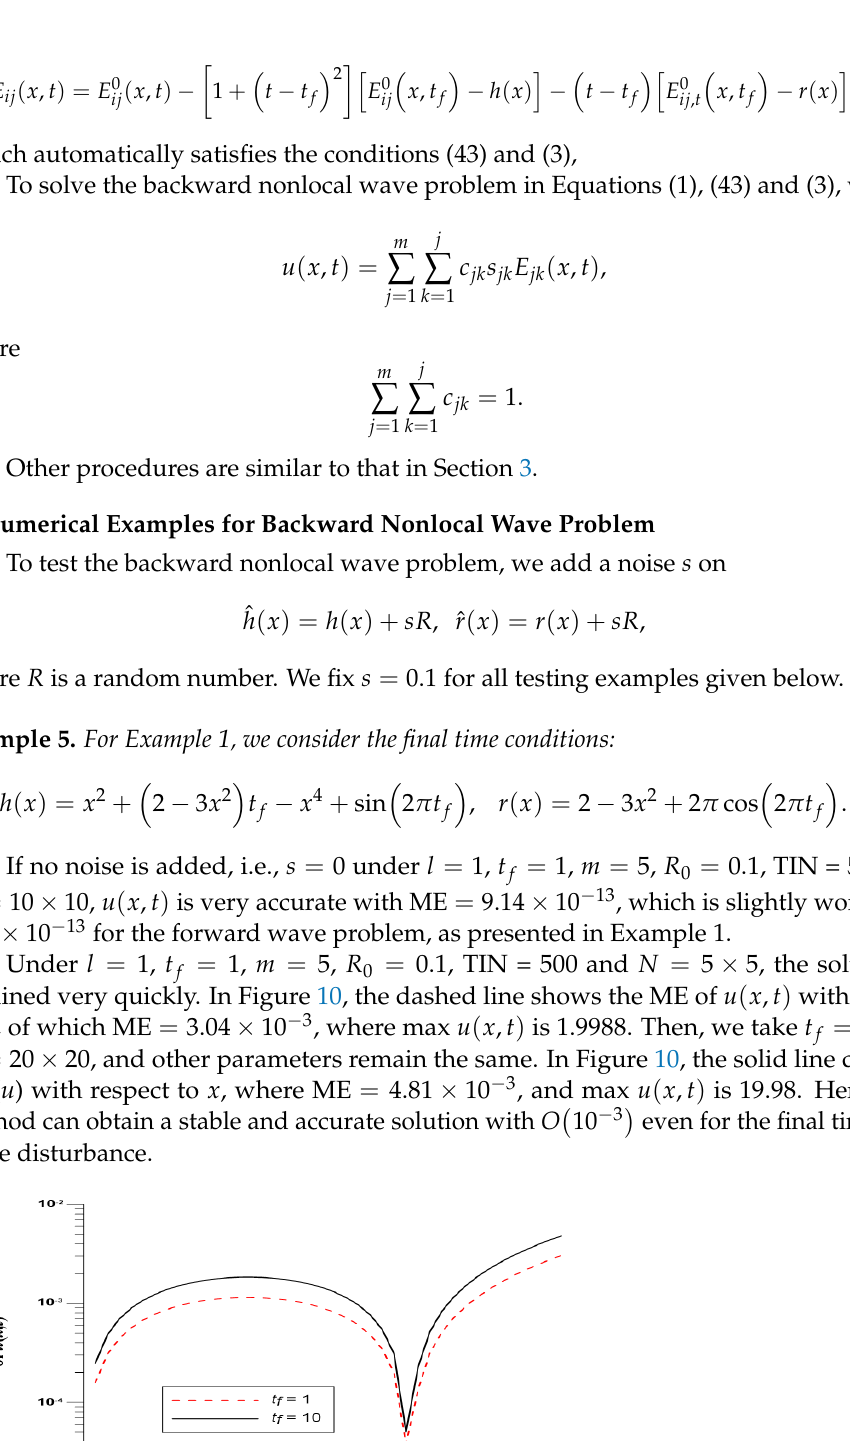
Figure 11. For Example 6 of the backward nonlocal wave problem: ME( u ) versus x in the spatial interval. Figure 12. For Example 7 of the backward nonlocal wave problem of the Klein–Gordon equation: ME( u ) versus x with different final times. 7. Complex Two-Side Nonlocal BCs The method presented in Section 5 is easily tailored to account for the backward non- local wave problem under complex two-side, nonlocal BCs: 𝑢𝑢 𝑡𝑡𝑡𝑡 ( 𝑥𝑥 , 𝑡𝑡 ) − 𝑢𝑢 𝑥𝑥𝑥𝑥 ( 𝑥𝑥 , 𝑡𝑡 ) = 𝐹𝐹 ( 𝑥𝑥 , 𝑡𝑡 ),